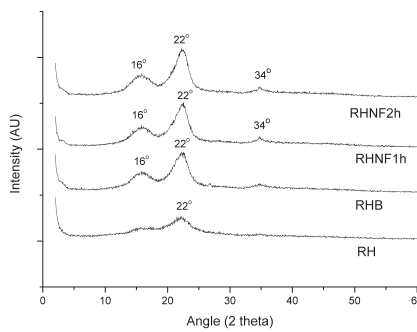
Figure 3. X-ray diffractograms of RH, RHB, RHNF1h and RHNF2h.